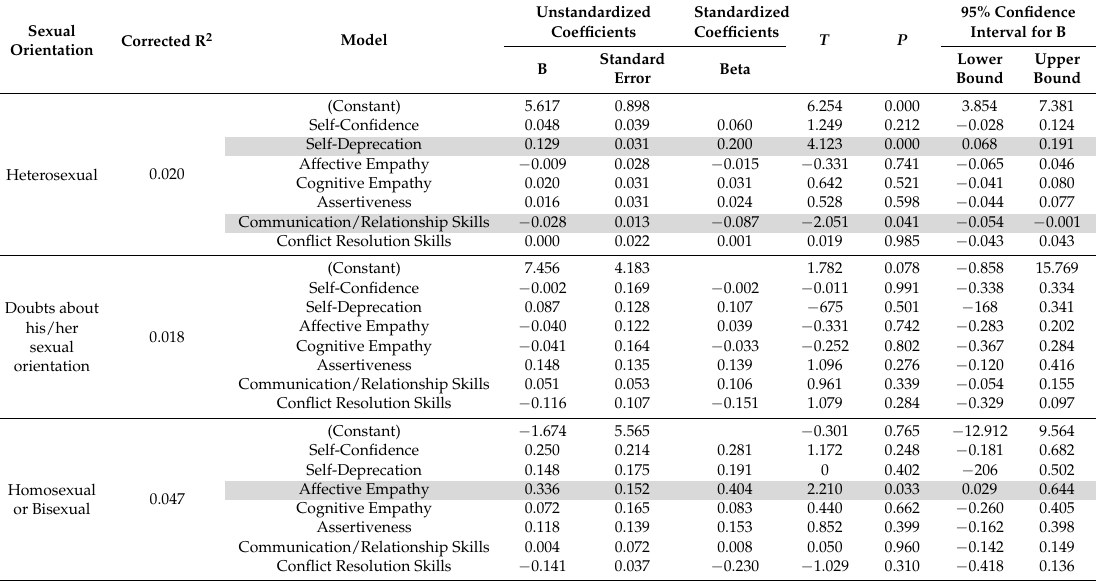
Gray background: significant